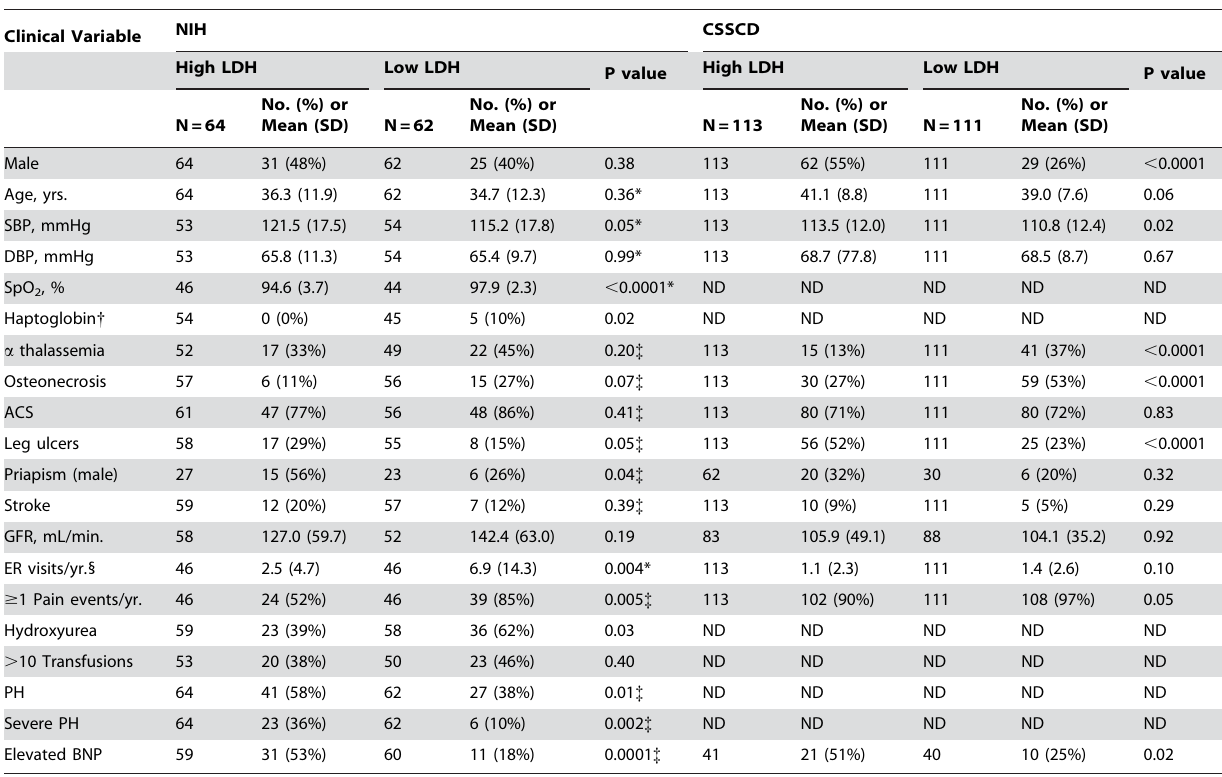
Table 2. Clinical Associations with the Hyper-Hemolysis Phenotype in Sickle Cell Anemia.